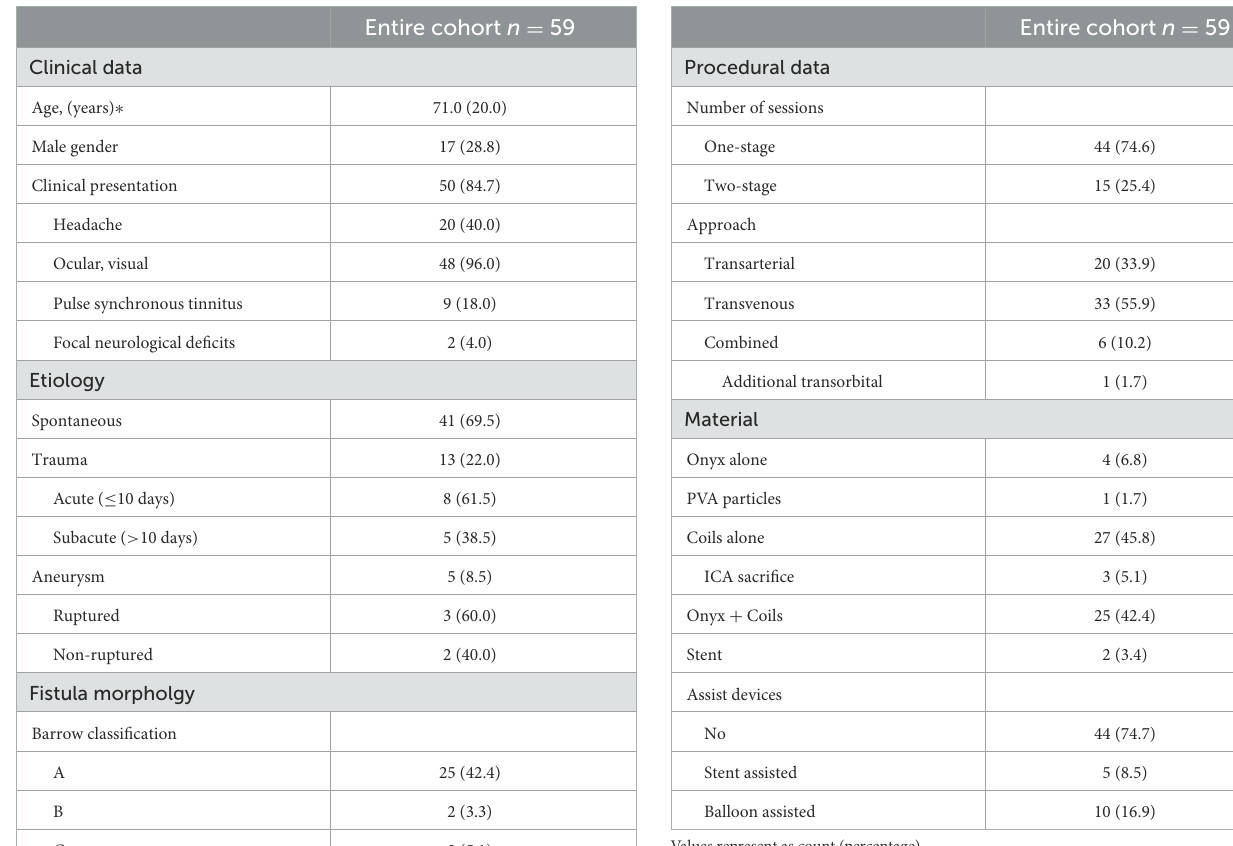
TABLE 1 Clinical data and fistula morphology. TABLE 2 Periprocedural data & embolization